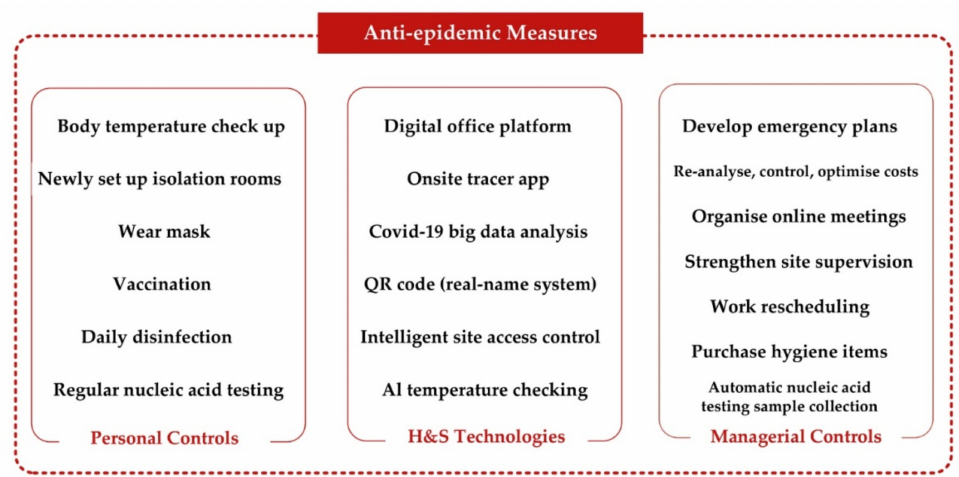
Figure 2. The COVID-19 preventive